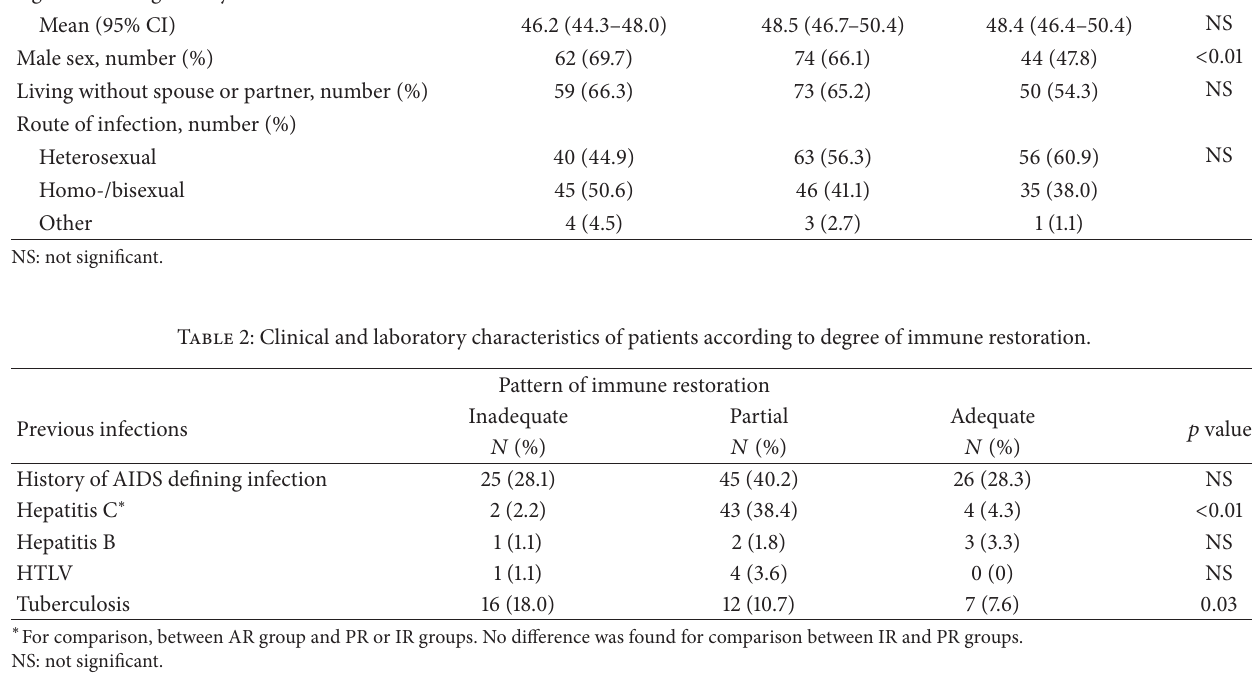
Patients characteristics